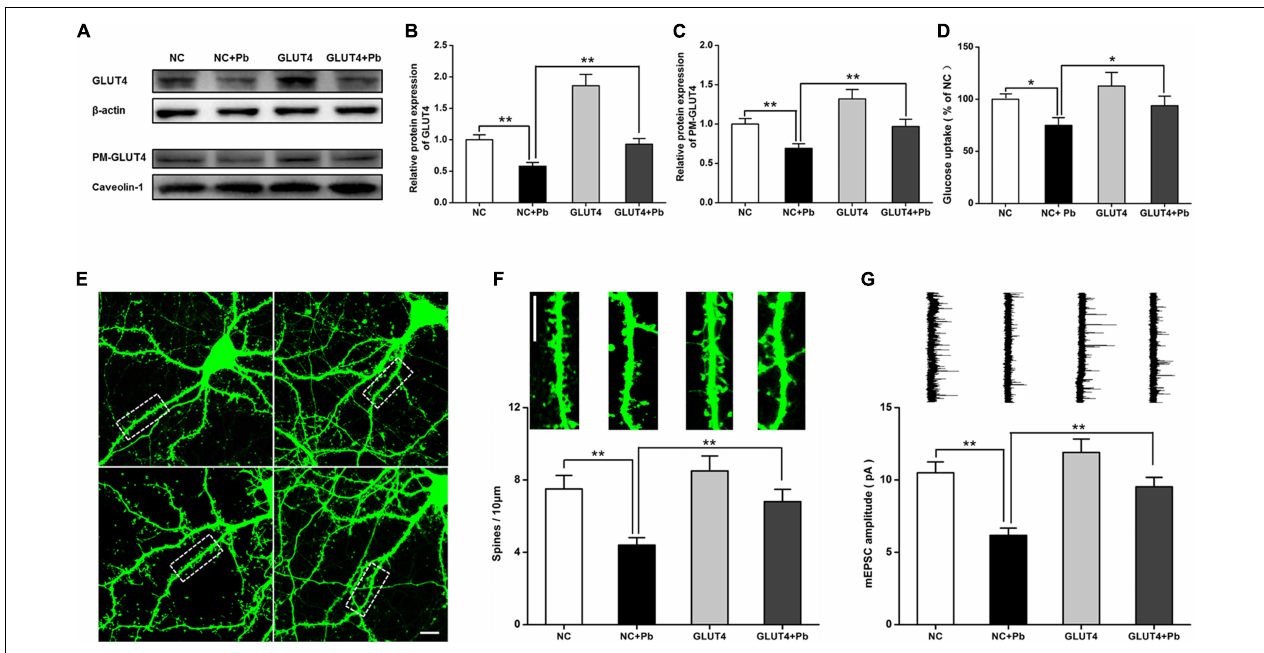
FIGURE 6 | Effects of over-expression of GLUT4 on glucose uptake and synaptic plasticity of primary hippocampal neurons in the Pb-exposed rats. (A–C) Expression changes in GLUT4 and PM-GLUT4 in rat hippocampal neurons after AAV-GLUT4 transfection. GLUT4 and PM-GLUT4 expression levels returned to normal in the rat primary cultured hippocampal neurons of the Pb-exposed group after AAV-GLUT4 transfection. Among them, caveolin-1 served as the loading control of PM-GLUT4, and β -actin for GLUT4. (D) Effect of GLUT4 over-expression on glucose uptake in rat hippocampal neurons. Over-expression of GLUT4 recovered the glucose uptake levels in the primary hippocampal neurons from the Pb-exposed group. (E–G) Effects of GLUT4 over-expression on cell morphology and LTP in Pb-exposed rat hippocampal neurons. After lentivirus infection, the morphology (dendritic spines) of rat primary cultured hippocampal neurons was observed via laser confocal microscopy. Over-expression of GLUT4 reversed the dendritic spine density and LTP lesions in Pb-exposed rats. Scale bar = 10 µ m. * p < 0.05, ** p < 0.01, vs. control, n = 6 per